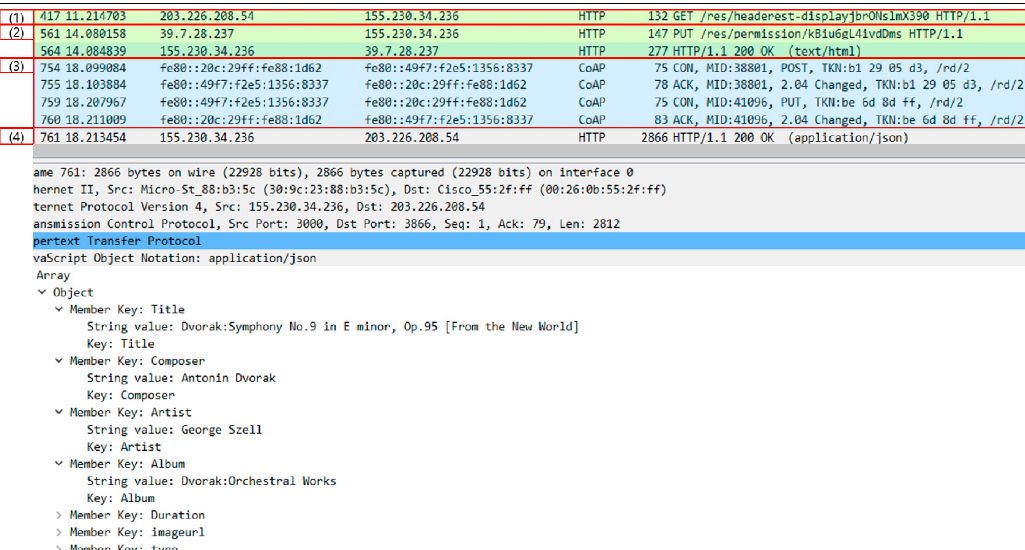
Figure 18. Packet capturing results for shared resource control by user.